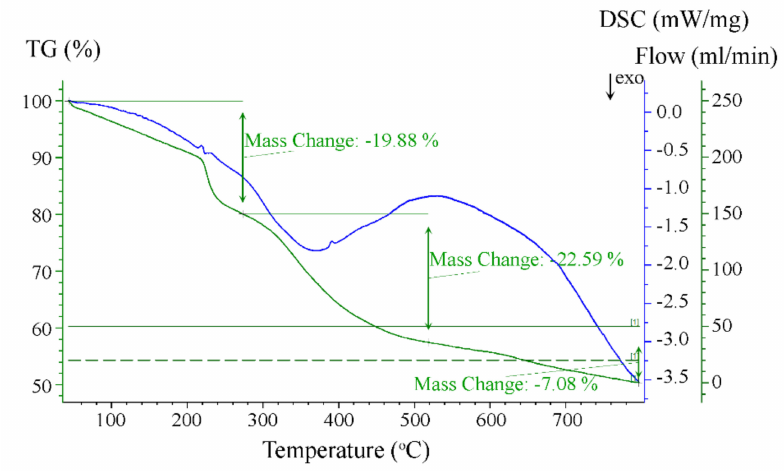
Figure 2. TGA and DSC diagrams of Ce x Ti y O z nanocontainers loaded with ATT.